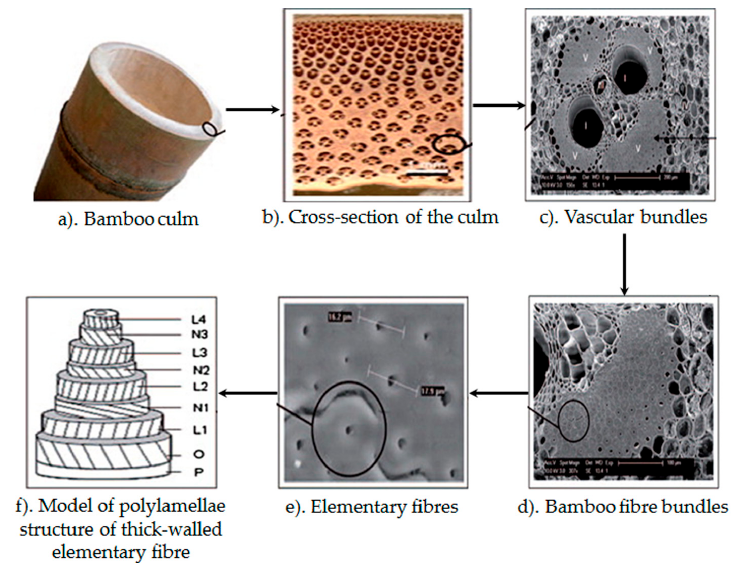
Figure 5. Bamboo microstructure [33].